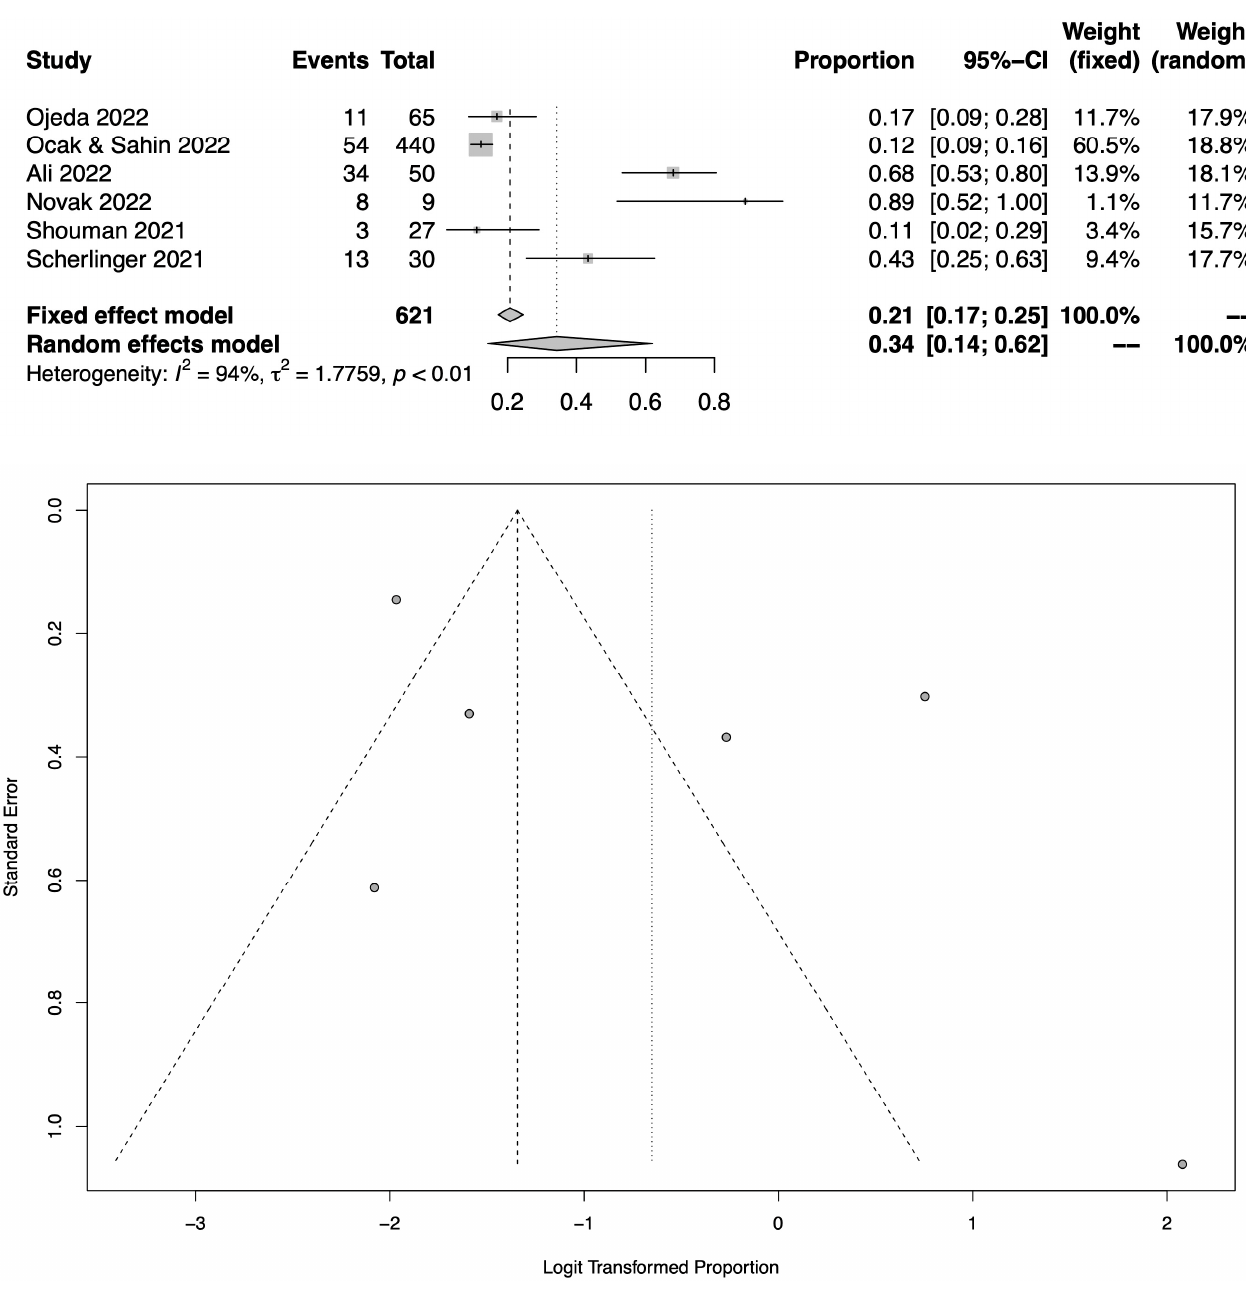
Figure 4. Meta-analysis results (all RCTs with available data) as illustrated in the forest plot and the respective funnel plot regarding the pooled prevalence estimation for COVID-19-related neuro- pathic pain amongst long COVID cohorts